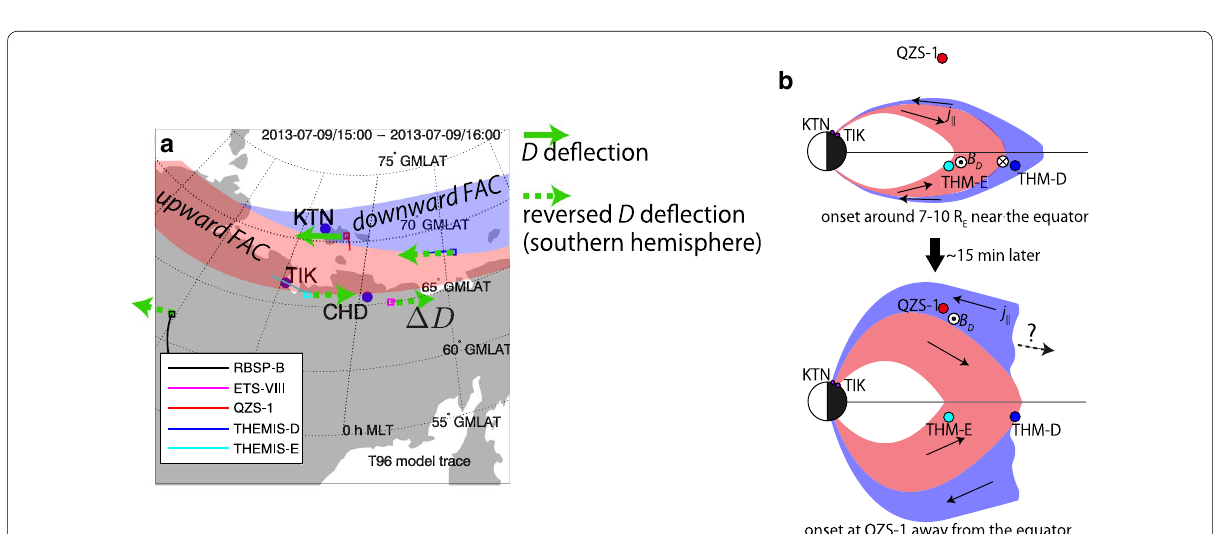
Fig. 4 Schematic illustrations of possible FAC distributions: a on the ionosphere at the time when magnetic fluctuations reached QZS-1 and KTN and b in the magnetosphere near the midnight meridional plane at the first onset and QZS-1 onset. The blue area shows the earthward (downward) FAC, and the red area shows the tailward (upward) FAC. The solid green arrow shows the direction of azimuthal magnetic field variation. The dotted green arrow shows the opposite direction of the azimuthal magnetic field variation observed in the southern hemisphere with respect to the magnetic